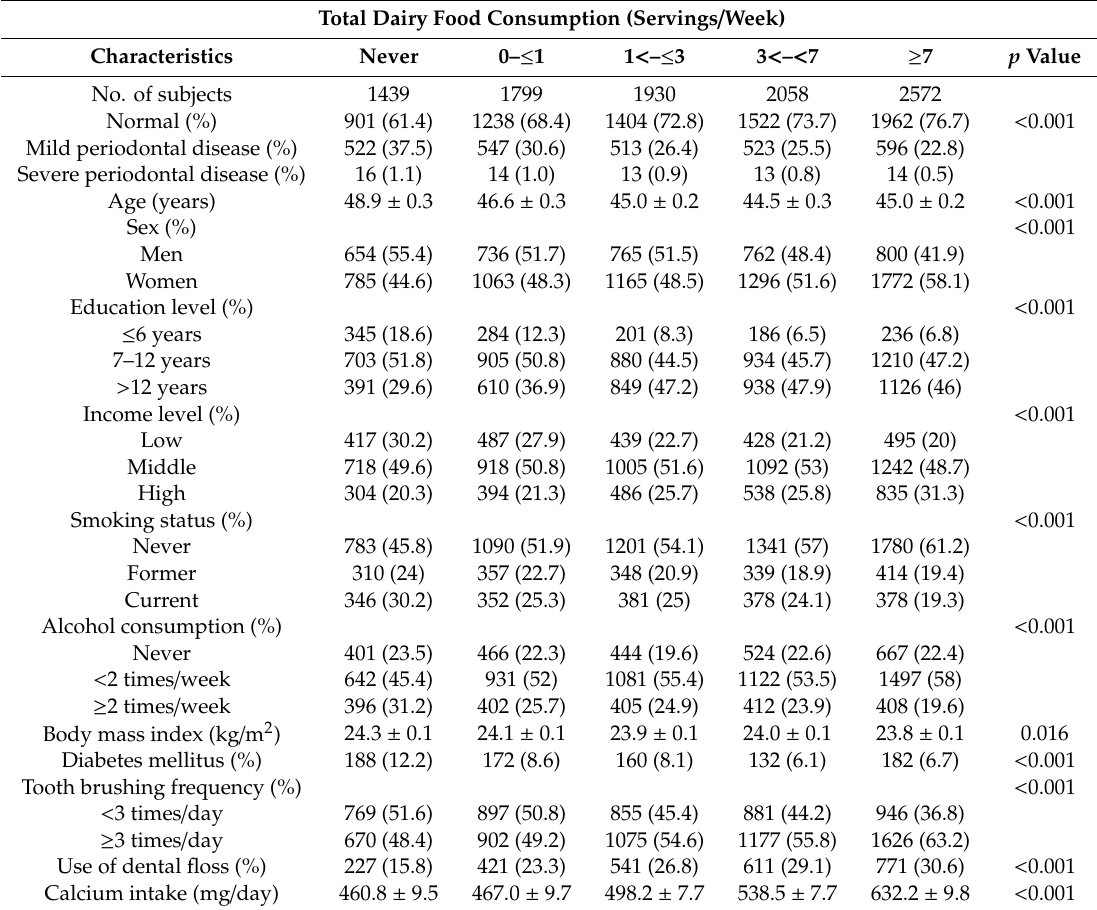
Table 2. General characteristics of participants according to total dairy food consumption 1